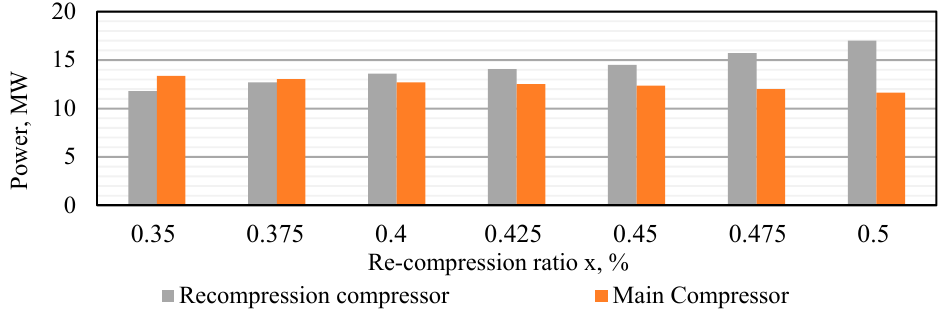
Figure 7. Technical performance comparison of recompression Brayton cycle.